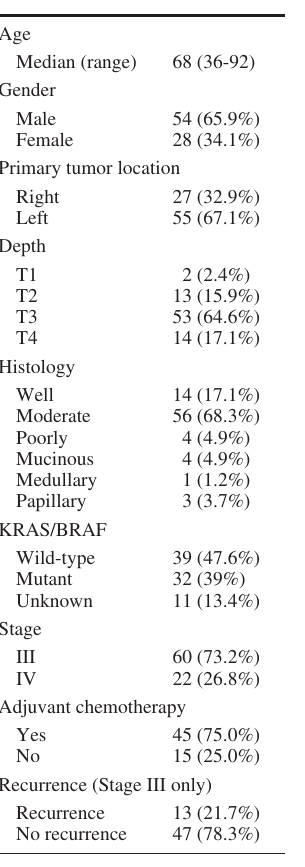
Table 1. Patient Characteristics.